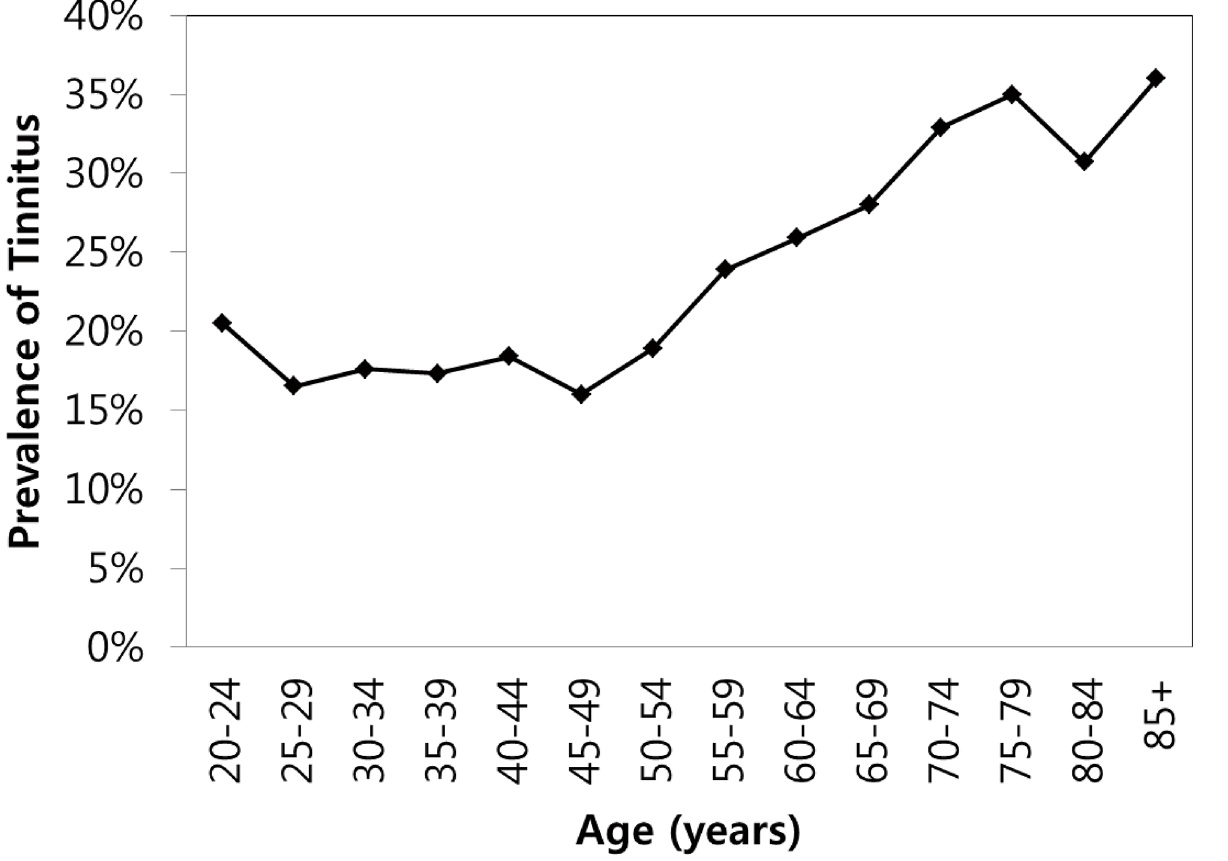
Fig 1. Prevalence of tinnitus in the Korean adult